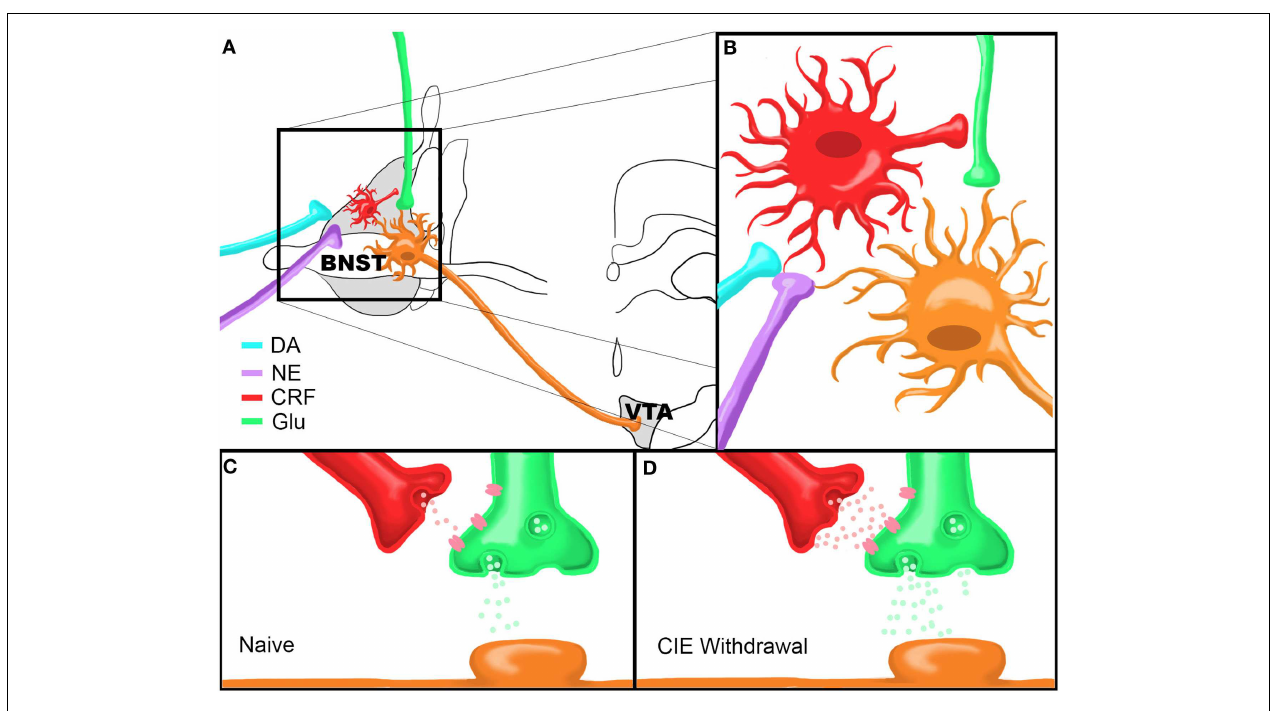
described in (A) . (C,D) Model of CRF modulation of glutamatergic transmission onto aVTA-projecting BNST neuron in a drug-naïve state (C) or during acute ethanol withdrawal following CIE (D) . Note that there are higher levels of CRF and glutamate release during withdrawal compared to the drug-naïve state. Figure reprinted from (Silberman et al.,